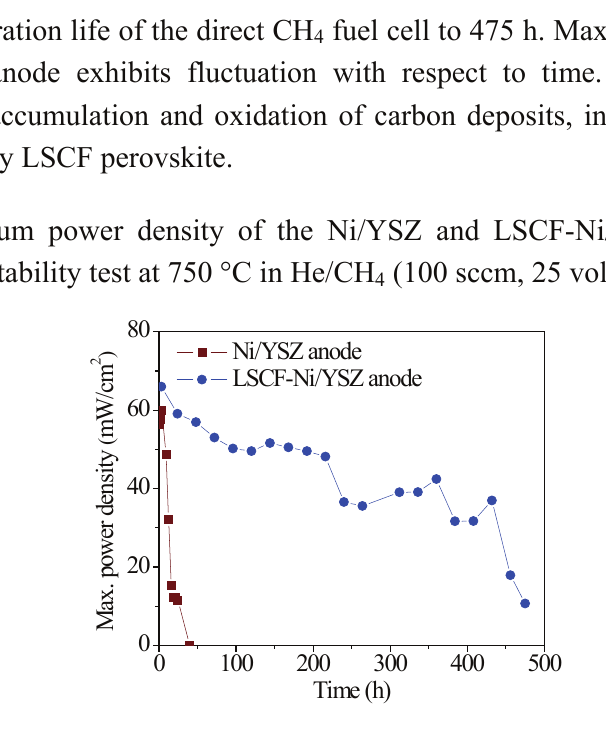
Figure 4. Maximum power density of the Ni/YSZ and LSCF-Ni/YSZ anode fuel cell during long-term stability test at 750 °C in He/CH